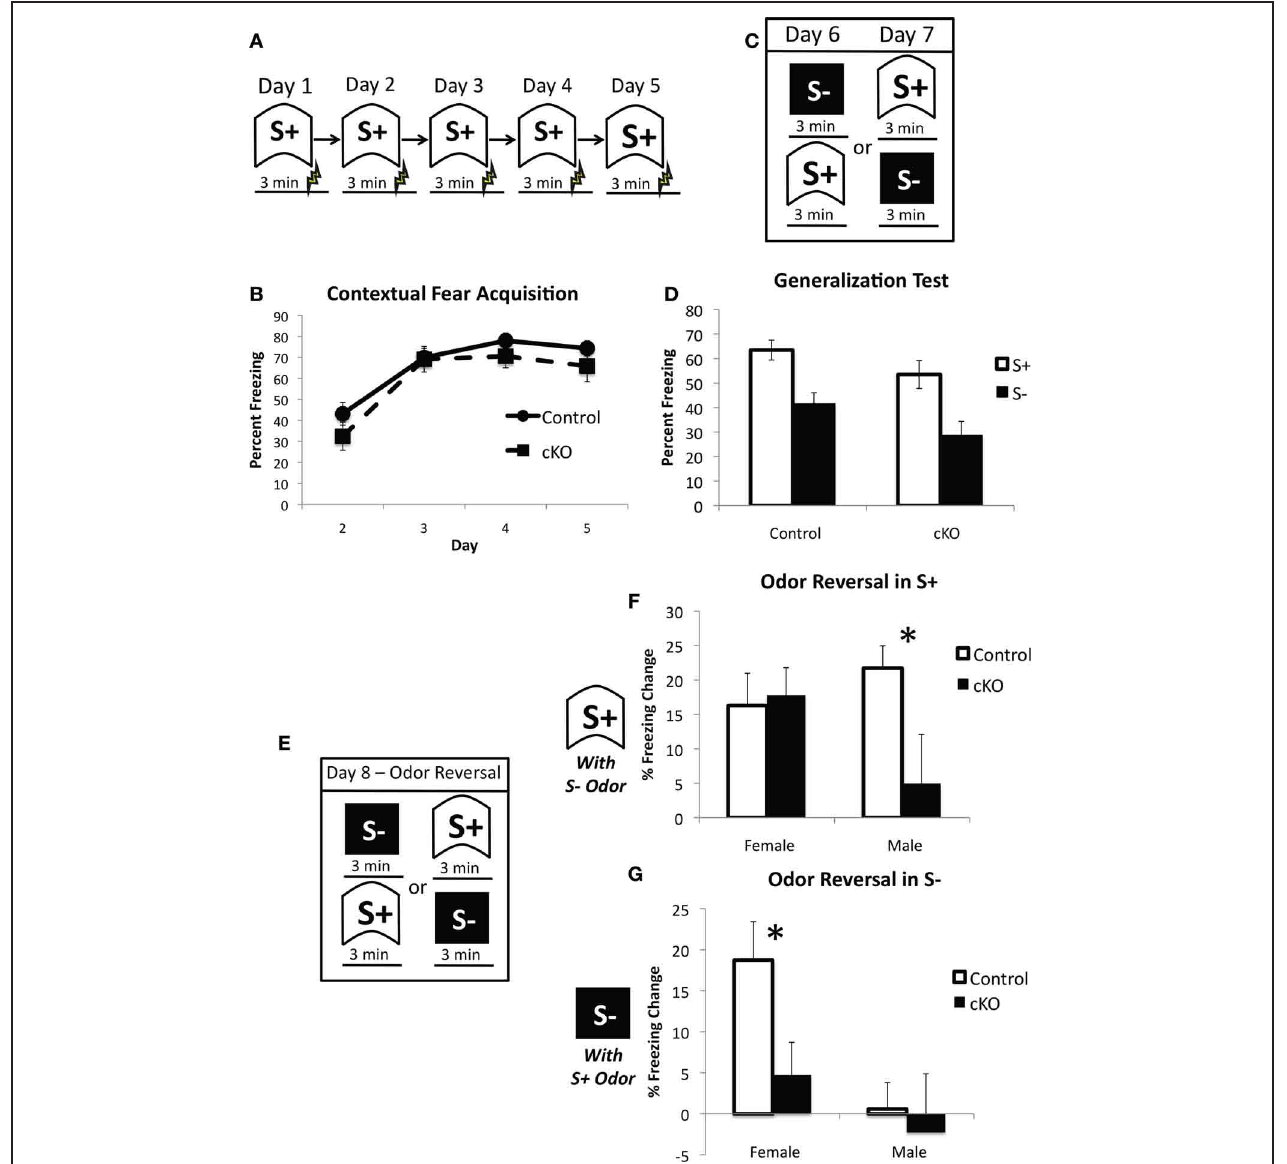
FIGURE 8 | DNMT1-cKO mice exhibit a sex-dependent impairment in odor-based discrimination. (A) Experimental design for the acquisition of fear to the training (S + ) context. Mice were placed in the conditioning chamber and shocked 3min later. (B) DNMT1-cKO mice exhibited normal context fear acquisition. (C) Experimental design for the generalization test. Mice were placed in both the S + and S − contexts over 2 days, with the order of exposure counterbalanced. These two contexts were structurally distinct and characterized by Windex and Simple Green odor, respectively. (D) DNMT1-cKO mice showed normal levels of freezing to the S + context and equivalent generalization to the S − context. (E) Experimental design for the odor reversal test on Day 8. Mice were again placed in both